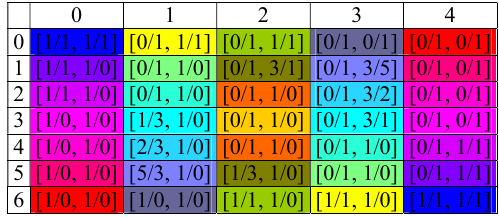
CIs at 5% risk of being in error for odds ratio in x , y , m = 6, n = 4 group of binomial experiment configurations ( x